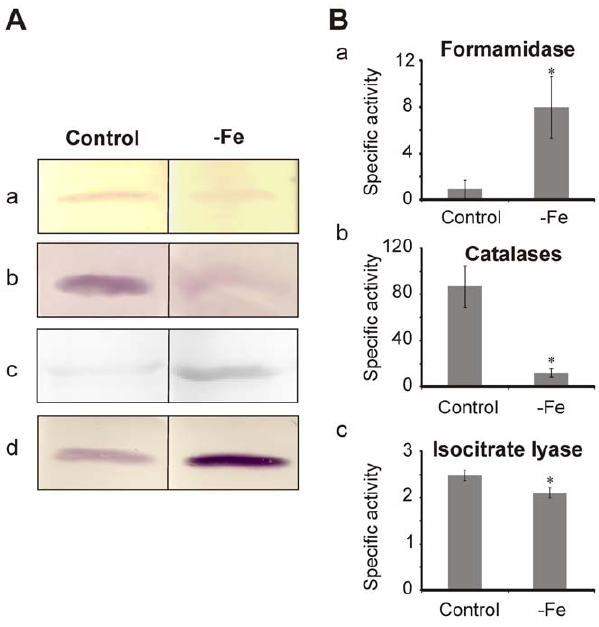
Figure 8. Western blot and enzymatic activity analysis validate proteomic data of P.brasiliensis yeast cells during iron-limiting condition. A) Western blot analysis of proteins probed with antibodies to (a) aconitase, (b) isocitrate lyase, (c) formamidase and (d) triosephosphate isomerase. B) Activity assay results from (a) formamidase, (b) catalases, (c) isocitrate lyase. Control represents yeast cells incubated for 24 hours in MMcM medium. 2 Fe represents yeast cells incubated for 24 hours in MMcM medium depleted of iron. Error bars represent standard deviation from three biological replicates while * represents p # 0.05.